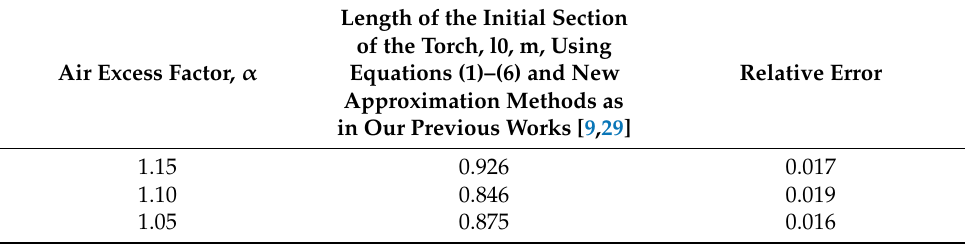
Table 3. Results of using new approximation methods for modeling the processes of signal transmis- sion from a rotating